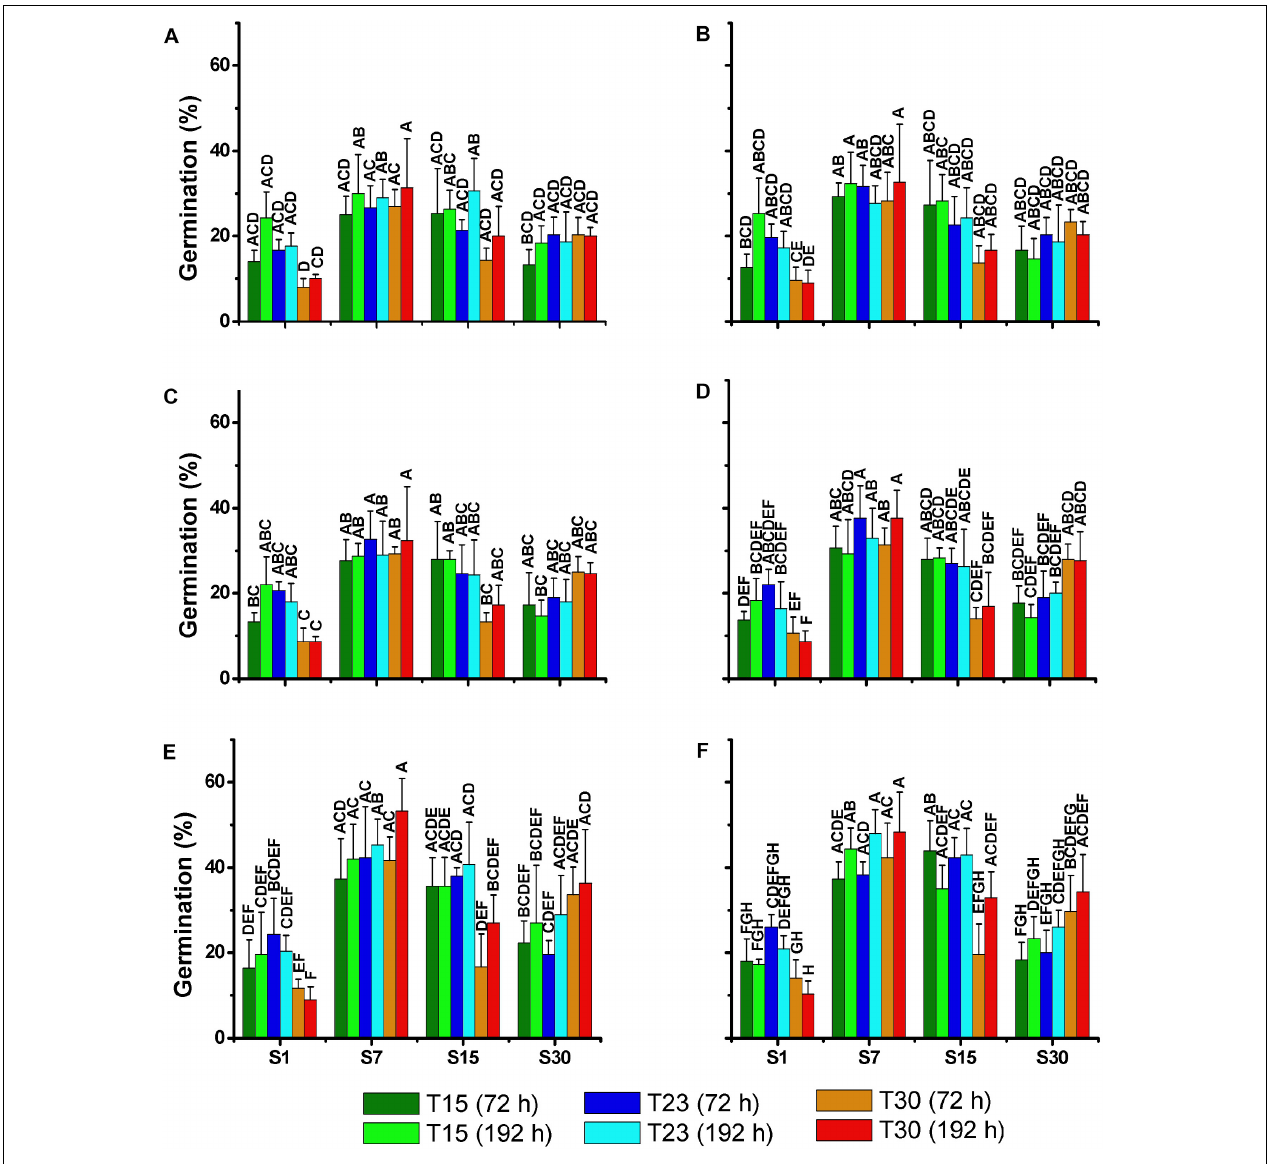
FIGURE 9 | Mean percentage ( ± SD; n = 3) of akinetes germination of N. spumigena (NODSPU1) after 72 and 192 h of exposure to different treatments. Significant differences are indicated by letters. Previous to the germination experiment, dark incubation lasted for 30 (A) , 60 (B) , 90 (C) , 120 (D) , 180 (E) , and 360 (F) days. Significant differences for each germination test are indicated by letters (ANOVA, Tukey’s p <